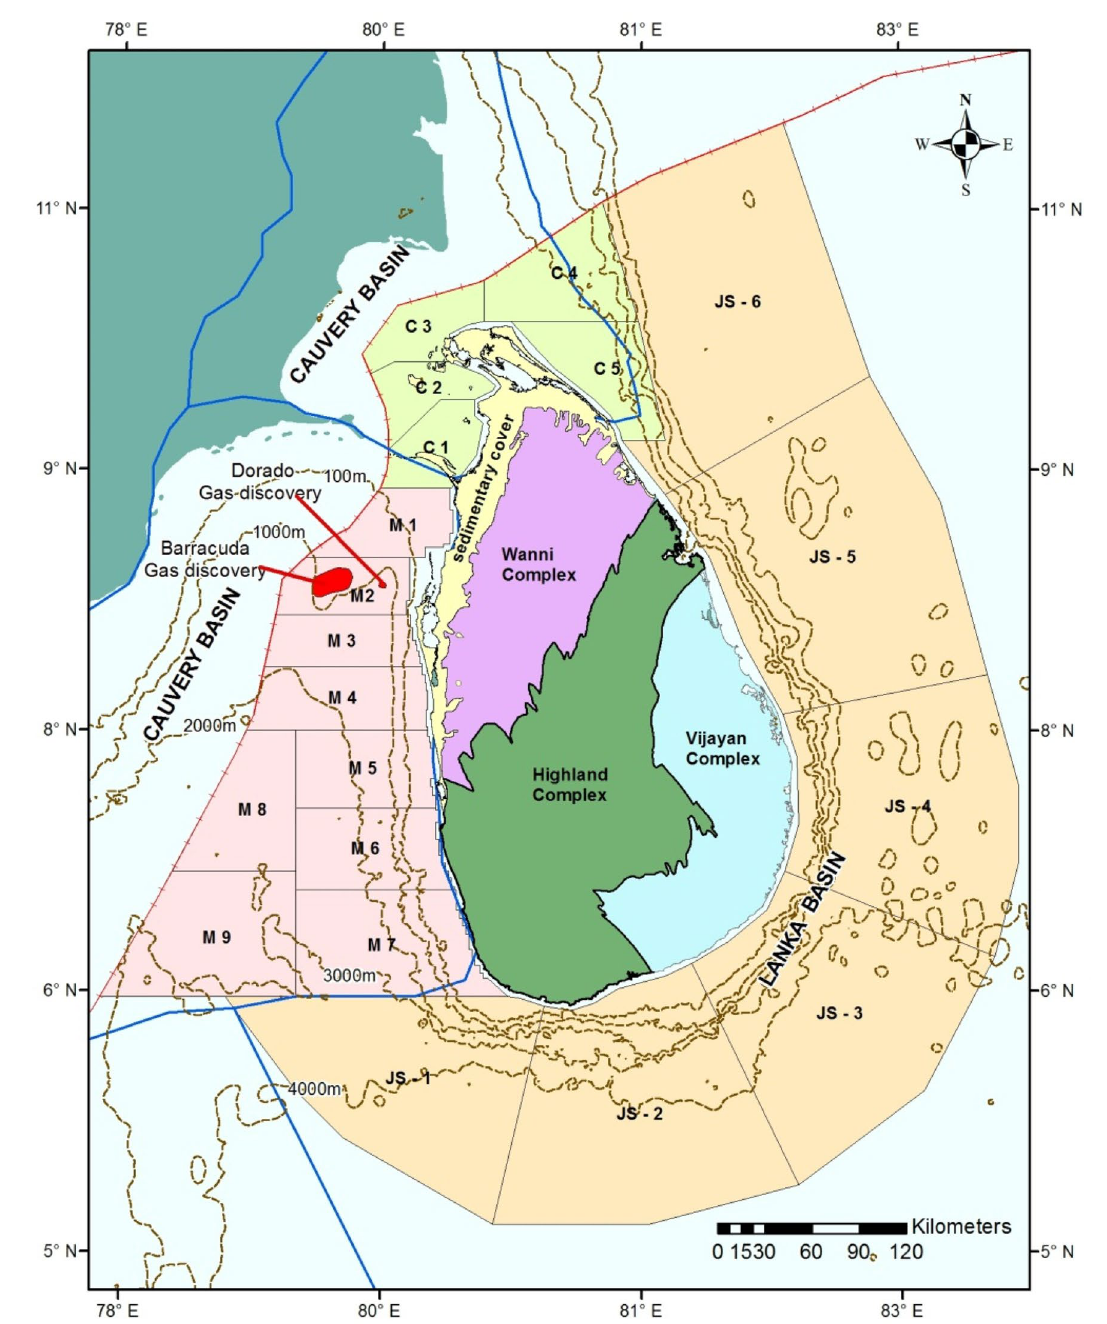
Fig. 1 Location of the three sedimentary basins (Cauvery, Mannar, and Lanka) in Sri Lanka, exploration blocks in the Mannar Basin (M1–M9), the Cauvery Basin (C1–C5) and Joint study blocks in the Lanka Basin